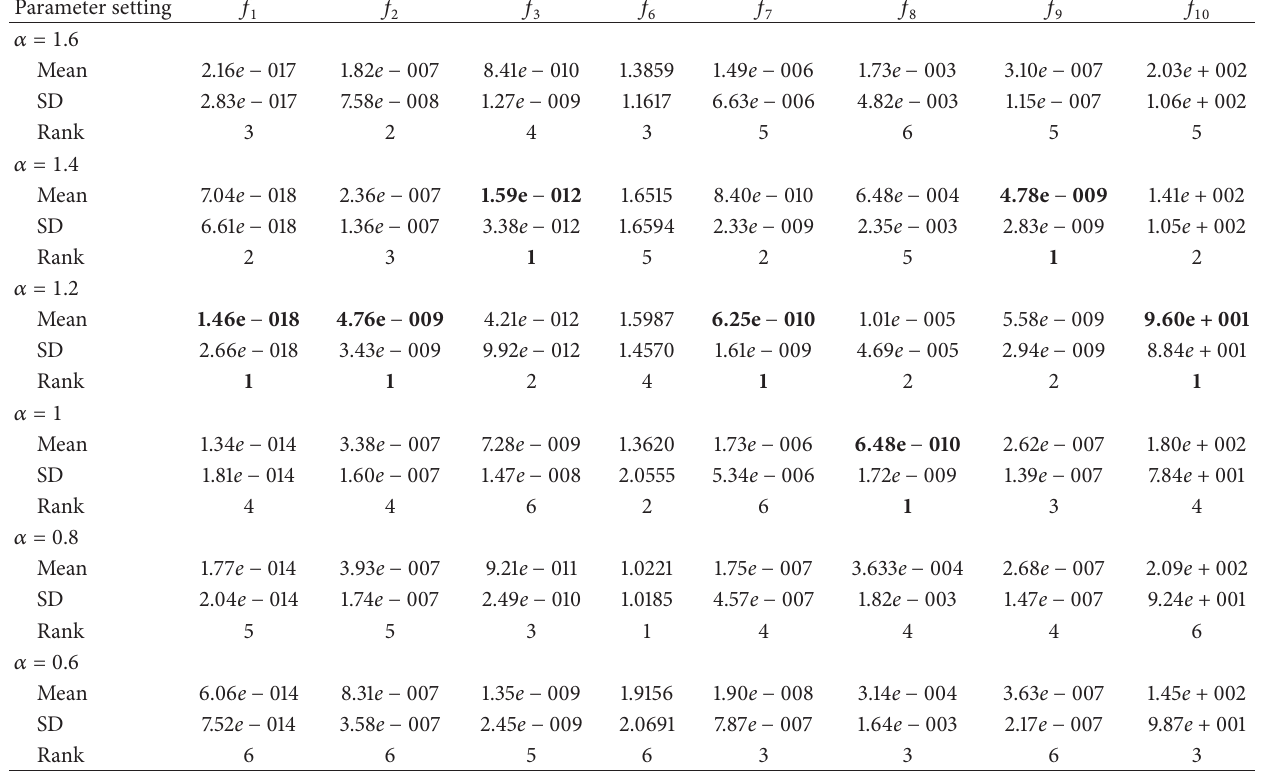
Table 3: Experimental results of different setting of 𝛼 in NTVS.